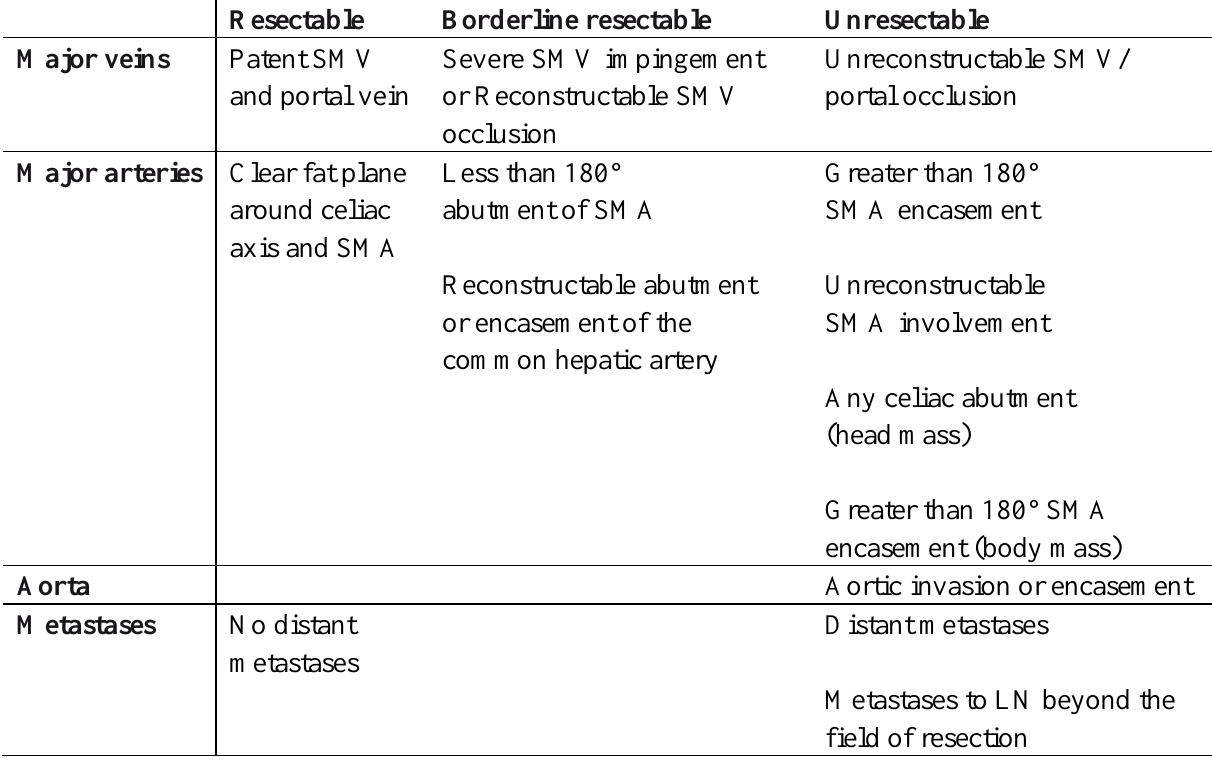
Table 1. CT-based criteria for categorizing a pancreatic cancer as resectable, borderline resectable or